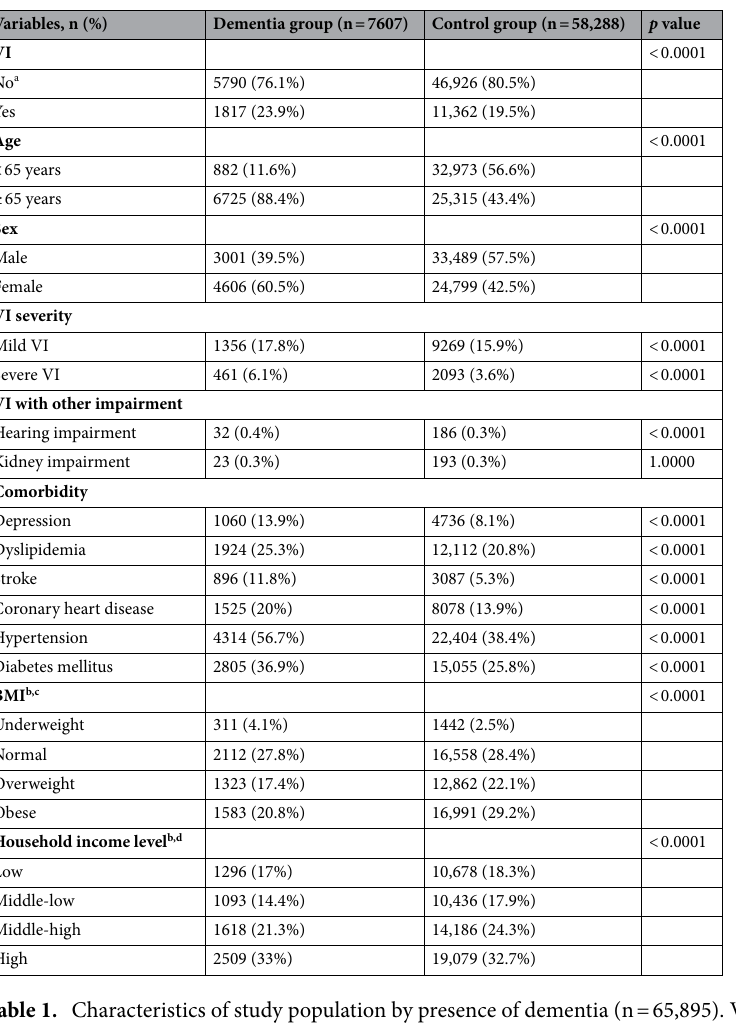
Table 1. Characteristics of study population by presence of dementia (n = 65,895). VI = visual impairment; BMI = body mass index. a Subjects who had never been diagnosed with V1 or other disabilities. b There exist missing values in data: 12,713 (19.3%) and 5000 (7.6%) of the entire population for BMI and household income level, respectively. c BMI was classified as normal (18.5–22.9), underweight (< 18.5), overweight